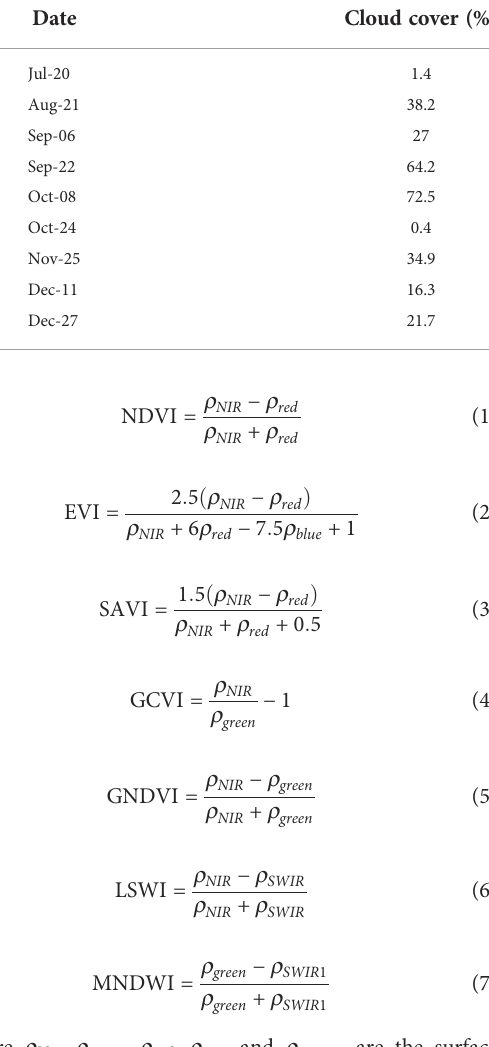
TABLE 1 Landsat 8 OLI images acquired in 2020 over the study